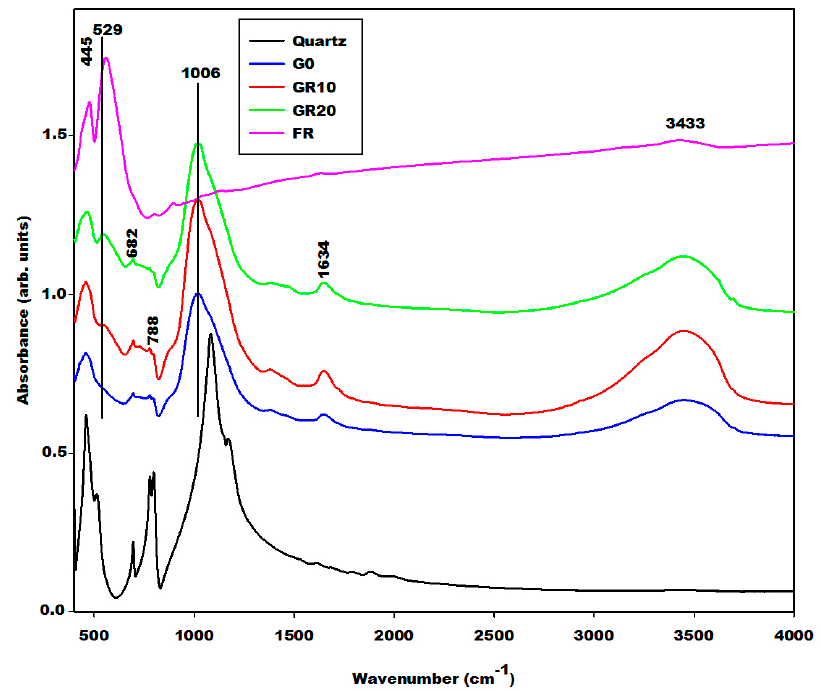
Figure 8. Infrared spectra of geopolymer materials (G0, GR10, GR20, quartz and FR: Hematite).